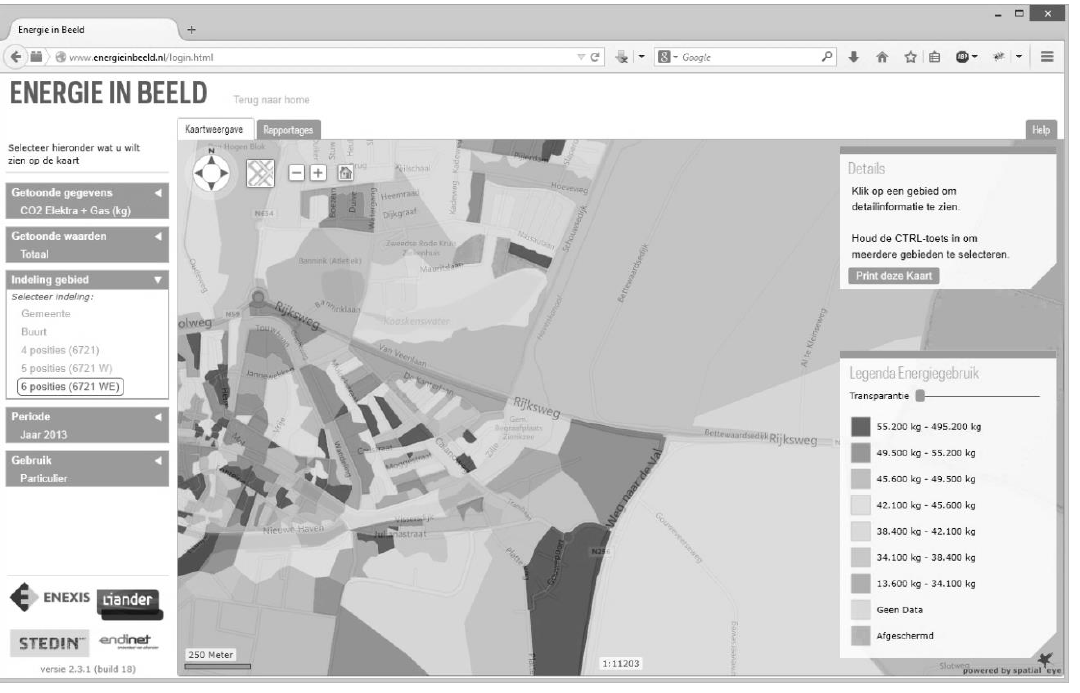
Figure 2. Sample of “Energie In Beeld” (Energy in Focus) web viewing service on the highest aggregation level (six-digit postcode level).